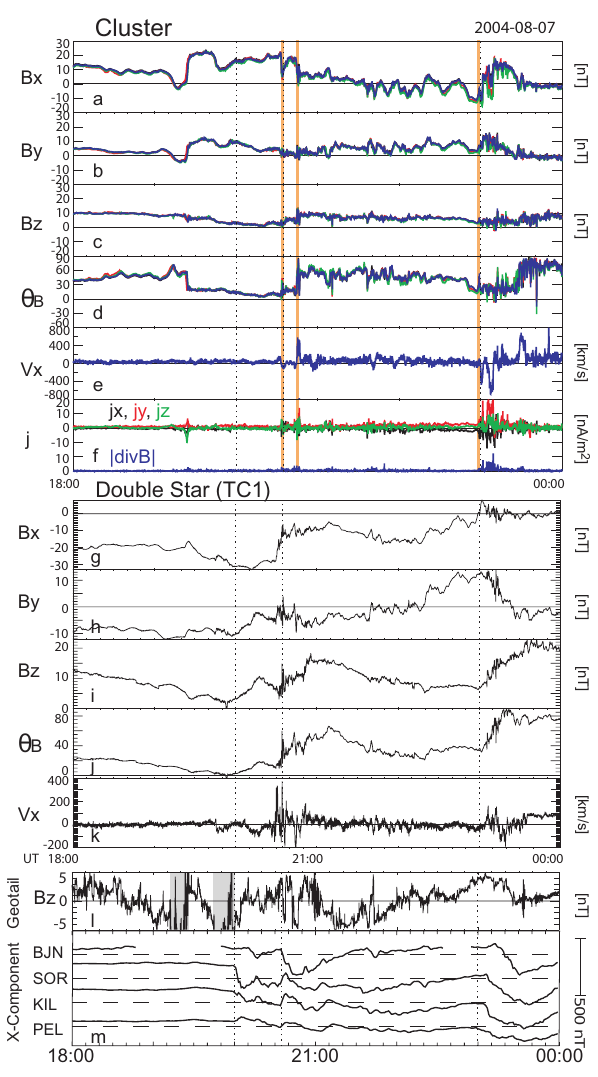
Fig. 1. (a) X , (b) Y , (c) Z components, and (d) latitude angle of the magnetic field and (e) X component of the proton flow from Cluster. (f) Current density and divergence of B estimated from the linear interpolation of the magnetic field from the four Cluster spacecraft. (g) X , (h) Y , (i) Z components, and (j) latitude angle of the magnetic field and (k) X component of the ion flow from Double Star TC-1. (l) X component of the magnetic field at Geotail in the solarwind and in the magnetosheath (shaded intervals). (m) X component of the ground magnetogram from selected MIRACLE stations: BJN (CGM lat. 71.45, CGM long. 108.07), SOR (67.34, 106.17), KIL (65.88, 103.79), PEL (63.55, 104.92). The vertical dotted lines show the onset time of the enhanced westward electrojet observed in the ground magnetogram, where as the orange lines indicate the onset of the B Z enhancement observed in